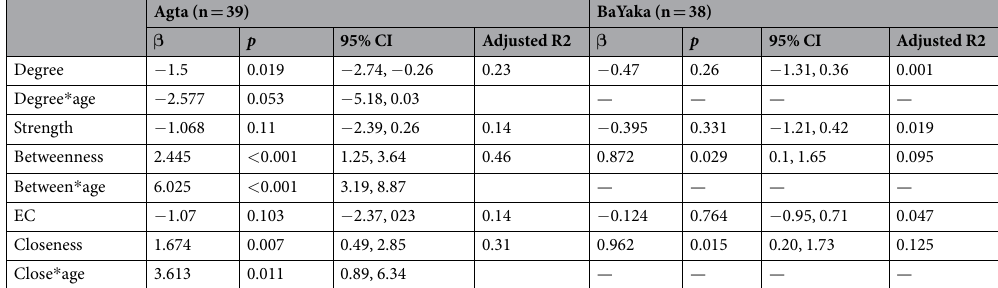
Table 2. Linear regression results for the relationship between five measures of centrality and age-controlled residuals for living offspring in the Agta and BaYaka. Age is mean centred at 36 years in the Agta and 41.7 years in the BaYaka. Models control for camp membership and all betas are standardised.